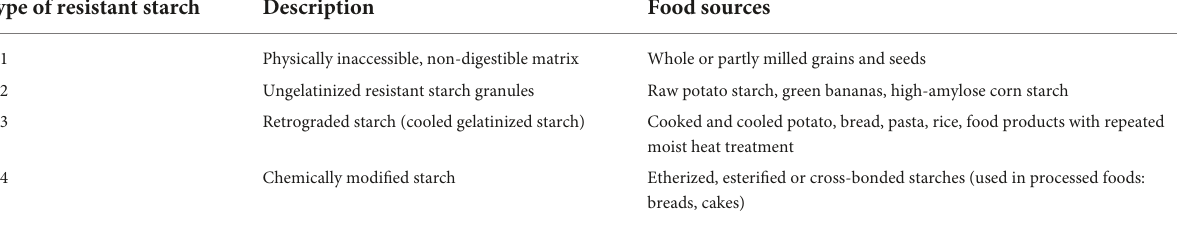
TABLE 1 Classification of types of resistant starch (RS) and food sources [adapted from Raigond, et al. (46)]. Type of resistant